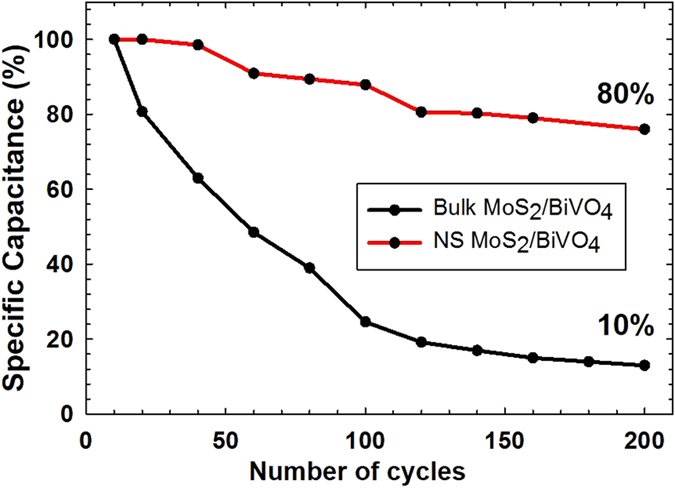
Cycling performance in terms of specific capacitance (%) of Bulk MoS2/BiVO4 and BiVO4-M at a current density 3 Ag−1.